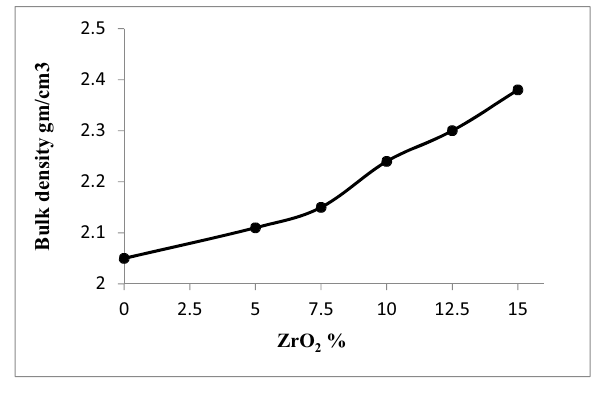
Figure 4: Bulk density for various ZrO 2 additions in refractory